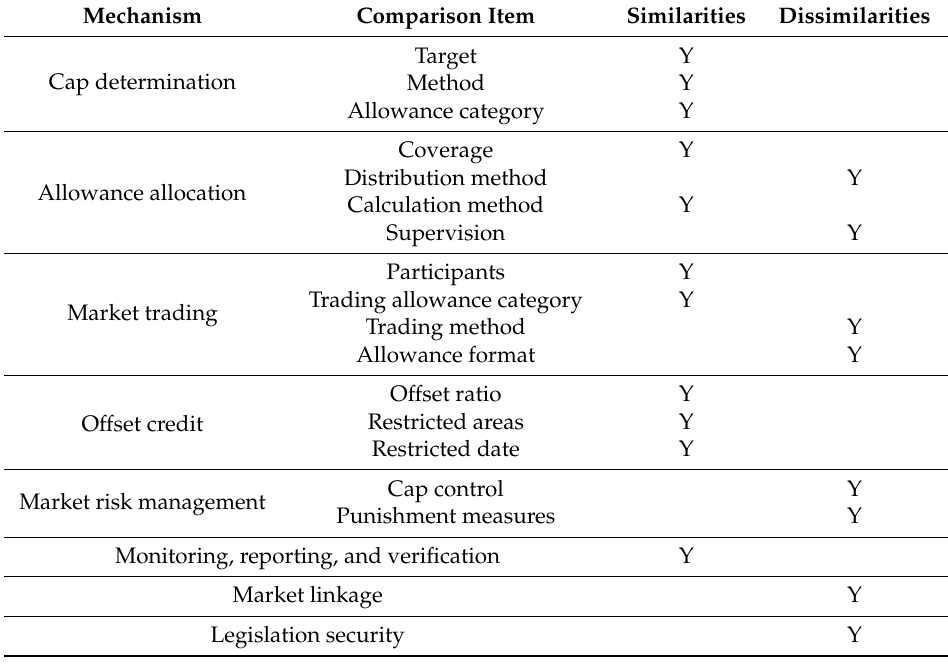
Table 11. Similarities and differences between EU ETS and China’s pilot ETS. Mechanism Comparison